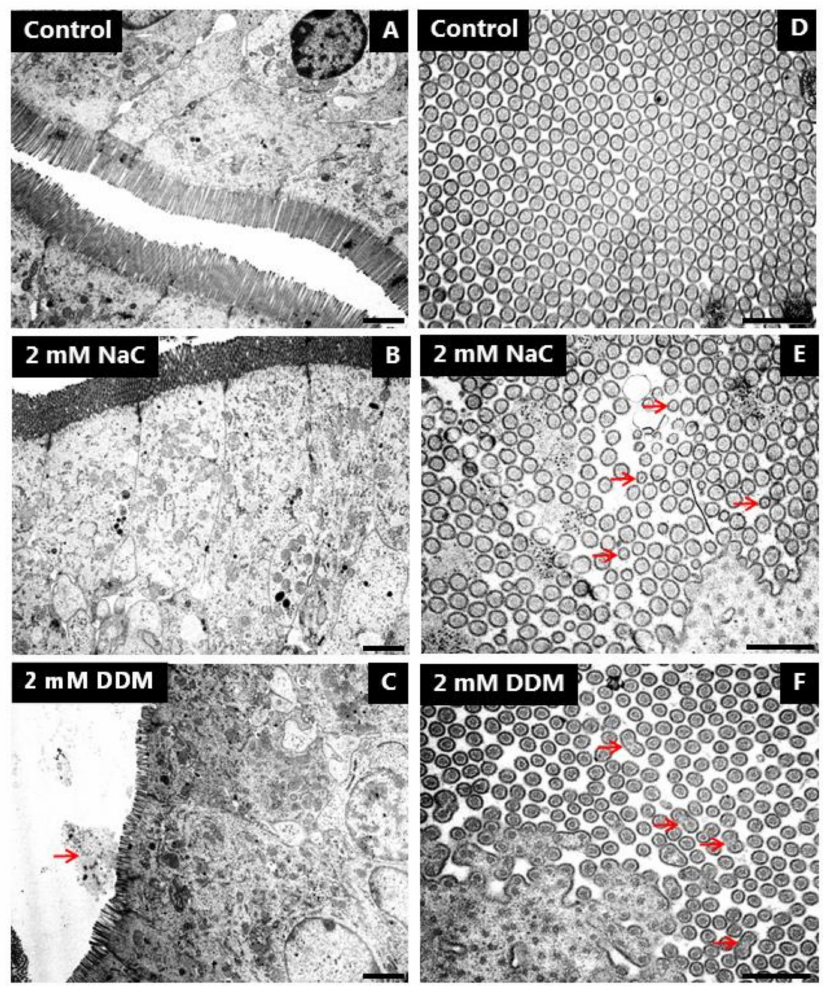
Figure 8. Effects of NaC and DDM on brush border ultrastructure. Electron micrographs showing longitudinal ( A – C ) and cross sections ( D – F ) of the brush border. (Arrows indicate apparent leakage into the lumen of cellular debris from the brush border in ( C ), microvilli with diminished diameter in ( E ) and fused microvilli in ( F ).) Bars: 1 µ m ( A – C ); 0.5 µ m ( D – F